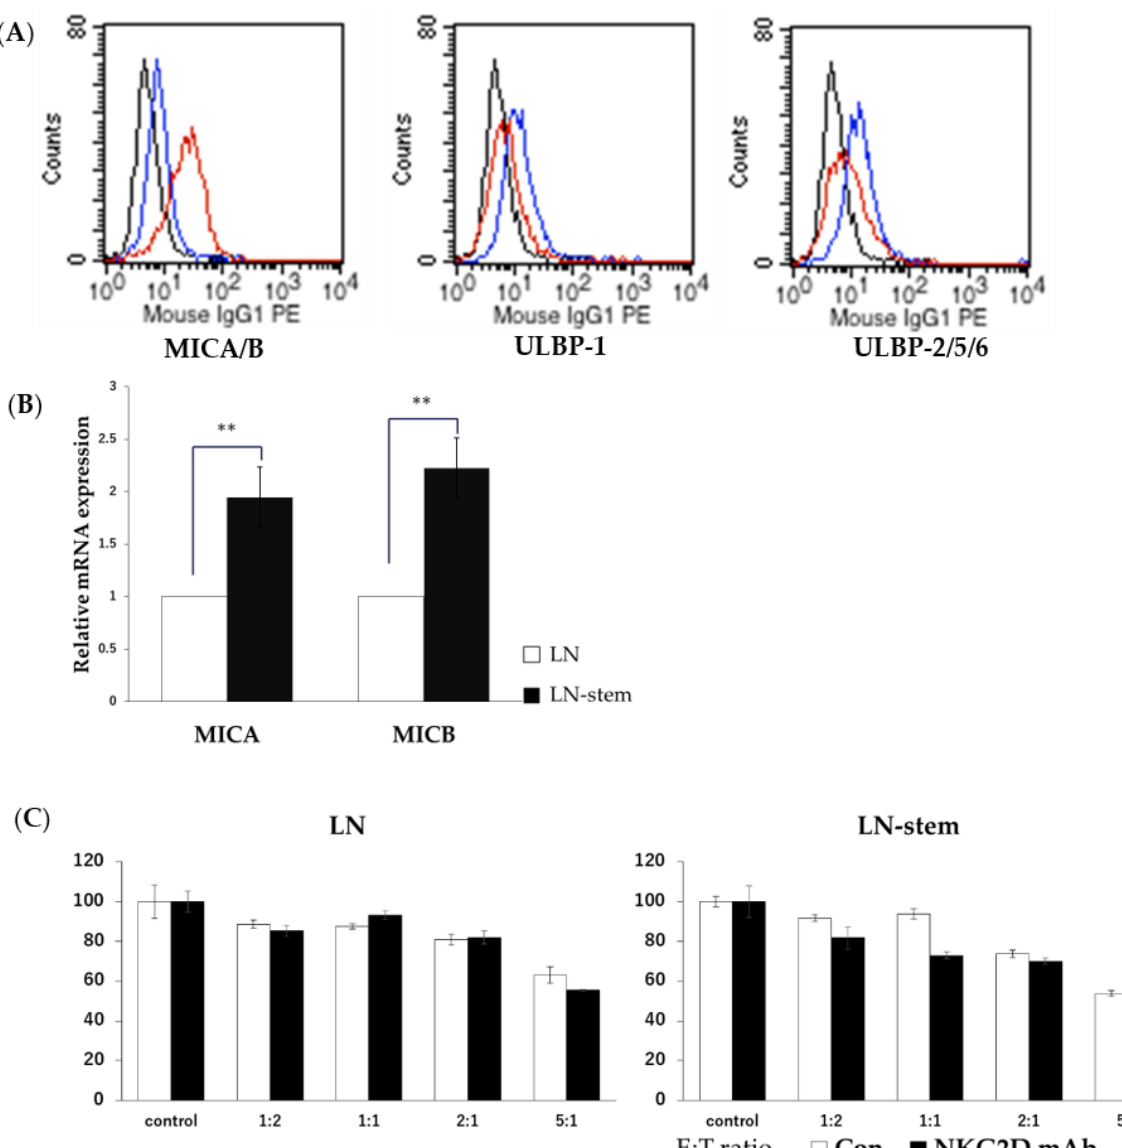
Figure 2. Relationship between NKG2D-MICA/B signaling and KHYG-1 cell-induced cytotoxicity against LN-stem cells. ( A ) Comparison of cell surface expression levels on NKG2D ligands (MICA/B, ULBP-1, and ULBP-2/5/6) between LN-stem cells and LN cells using FACS. Black, blue, and red lines indicate the matched isotype control, LN cells, and LN-stem cells, respectively. Values in the blue and red boxes indicate MICA/B-positive cell percentages for LN cells and LN-stem cells, respectively. ( B ) mRNA levels of MICA and MICB in LN cells and LN-stem cells. Each column indicates the mean, and vertical lines indicate SEM (n = 3). Values for LN cells are expressed as 1, and values for LN-stem cells are expressed as ratios relative to LN cells. ** p < 0.01 when compared with LN cells. ( C ) The effect of anti-NKG2D antibodies (treatment concentration 10 µ g/mL) on KHYG-1-induced cytotoxicity against LN-stem cells or LN cells when co-cultured for 72 h. Cell viability was determined by the WST-8 assay. Values for the control are expressed as 100%, and values for the other groups are expressed as percentages of the control. Data are means ± SEM from six samples. E/T: the ratio of KHYG-1 cells to LN-stem cells or LN cells.